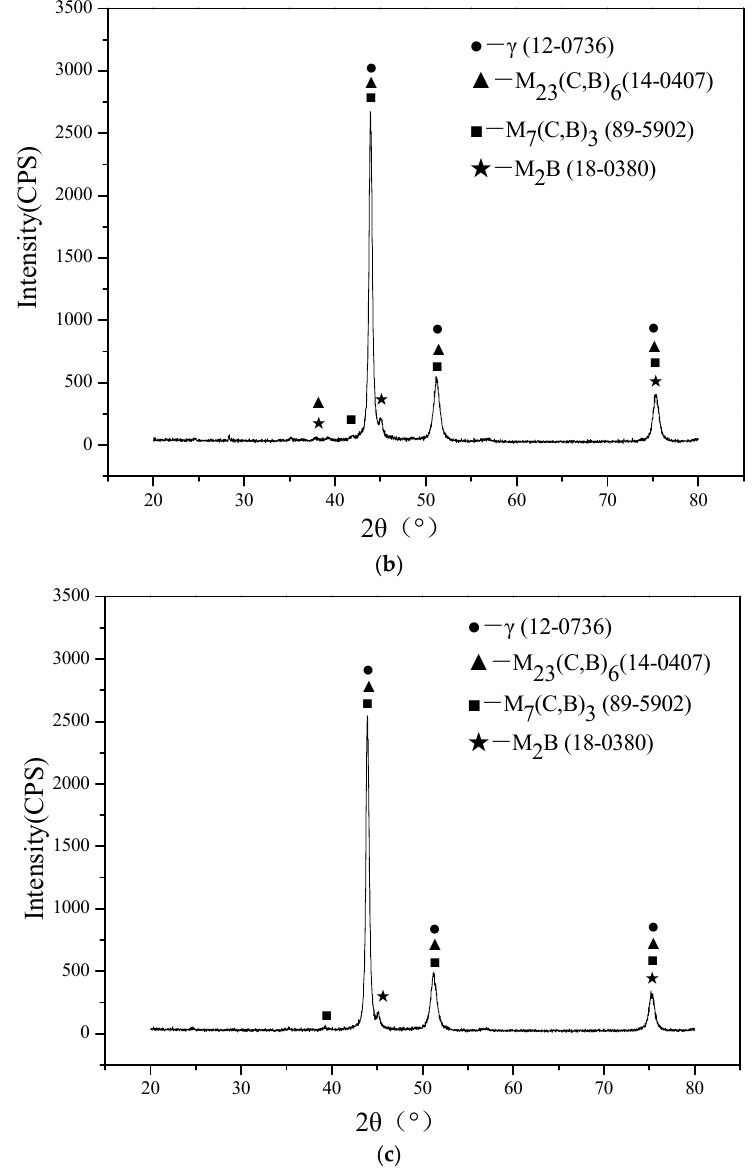
Figure 2. The XRD spectrum of the cladding layer: ( a ) NiCo00; ( b ) NiCo15; ( c ) NiCo30. Figure 3 presents the optical micrographs of the cladding layers with different Co contents. From Figure 3a,c, light lines can be seen between the substrates and the cladding layers; these light lines are fusion lines indicating that good metallurgical bonding has been achieved between the substrates and the cladding layers. From Figure 3, it can be seen that the microstructure of the cladding layer is transformed from columnar dendrites to equiaxed grains with the increase of the distance from the fusion lines. The microstructure of the cladding layer is mainly determined by the ratio (G/R) of temperature gradient (G) and solidification rate (R) during solidification. When the value of G/R is large, the microstructure usually grows as columnar dendrites. When the value of G/R is small, the microstructure is developed as equiaxed grains [35]. The temperature gradient (G) decreases, while the solidification rate (R) increases from the bottom to the top surface of the molten pool [1,36]. This means that the G/R decreases from the bottom to the top surface of the molten pool during solidification. Therefore, the microstructure of the cladding layer transforms from columnar dendrites to equiaxed grains with the increase of the distance from the fusion